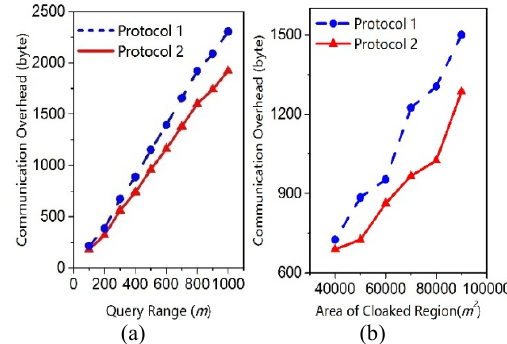
Fig. 7. Communication overhead of baseline and enhanced protocol. (a) Communication overhead, variable query range, . S R2 = m 2 ; (b) Communication overhead, variable cloaking region size, r = 1000 4 6 × 10